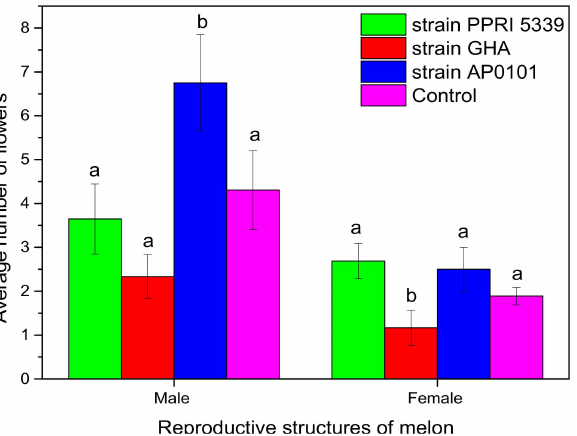
Figure 9. Average number of male and female flowers per C. melo plants inoculated with B. bassiana. Treated plants were watered with 10 mL of B. bassiana conidial suspension of 10 8 conidia/mL on the stage of four leaves, and means of the same flower type marked with the same letter did not differ significantly (Tukey-Kramer test, p < 0.05).